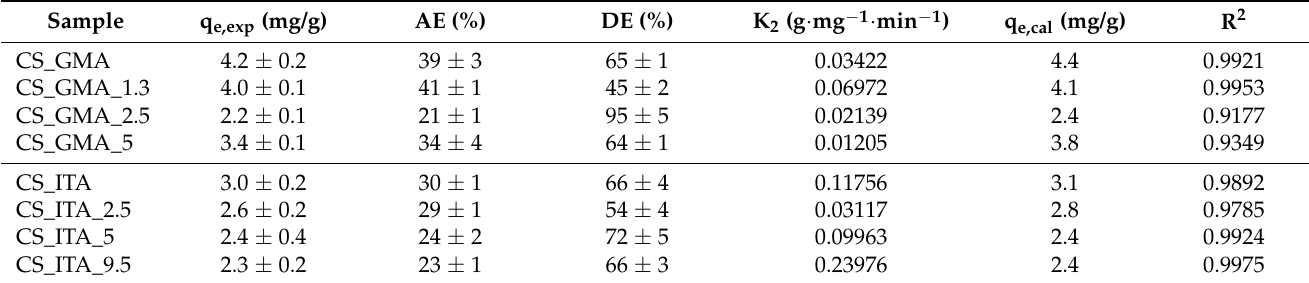
Table 3. Maximum amount of absorbed 2,4 D per gram of sorbent phase (q e ); absorption efficiency (AE) and desorption efficiency (DE); rate constant of pseudo-second-order adsorption (K 2 ); theoretical absorption capacity from pseudo-second-order model (q e,cal ); correlation coefficient (R 2